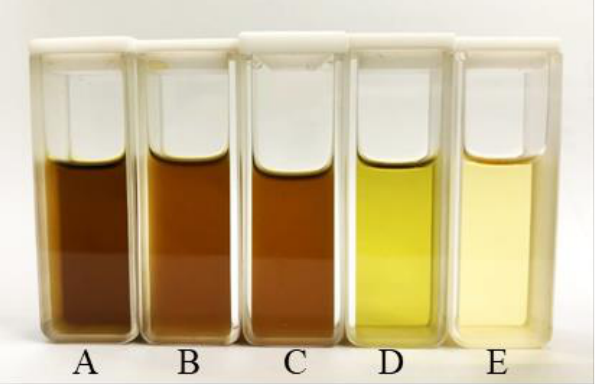
Figure 6. Solution of rhein-rich extract ( A ) from S. alata leaves with an intense brownish color decolorized using palm oil ( B ), coconut oil ( C ), aluminum oxide ( D ) and activated charcoal ( E ) as the decolorizing agents. Table 11. Rhein content, total phenolic content, antioxidant activity, anti-inflammatory activity and antibacterial activity against S. aureus of rhein-rich extract and its de-chlorophyll extracts.